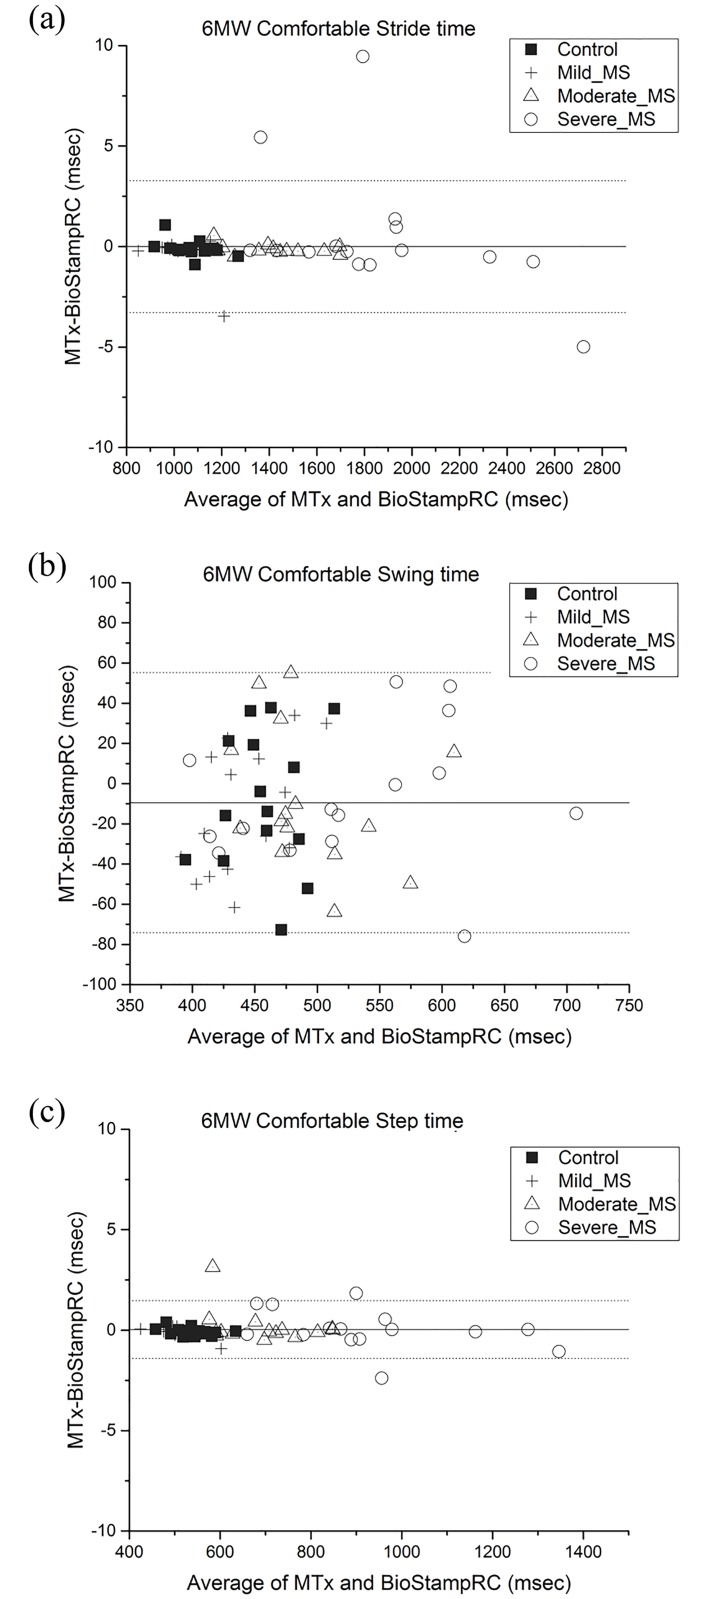
Bland-Altman plot of (a) Stride time (b) Swing time (c) Step time of BioStampRC compared with that of reference system (MTx).Limits of agreement are specified as average difference (solid line) and ±1.96 standard deviation of the error (dotted line).